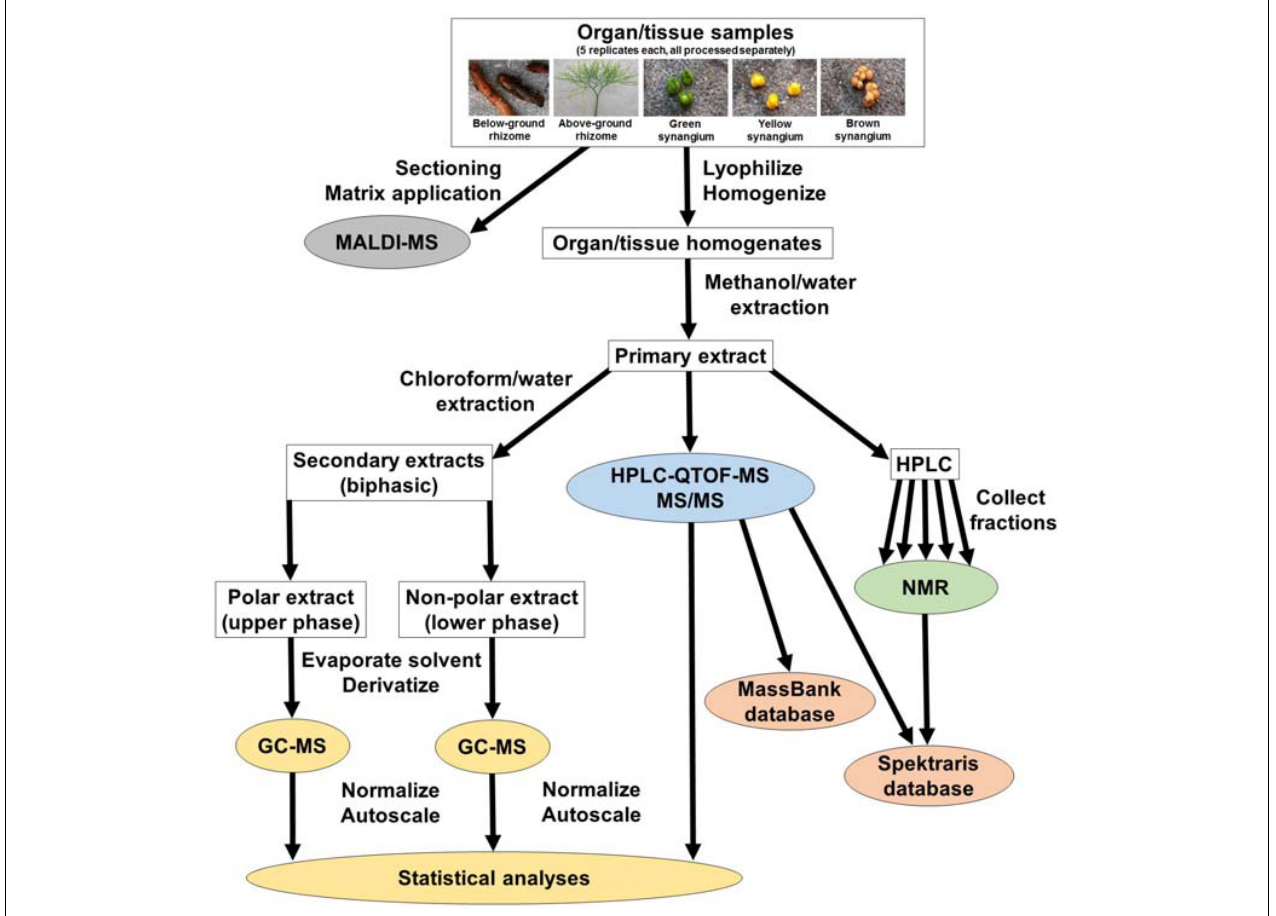
FIGURE 1 | Experimental design for the current study. For details and abbreviations see